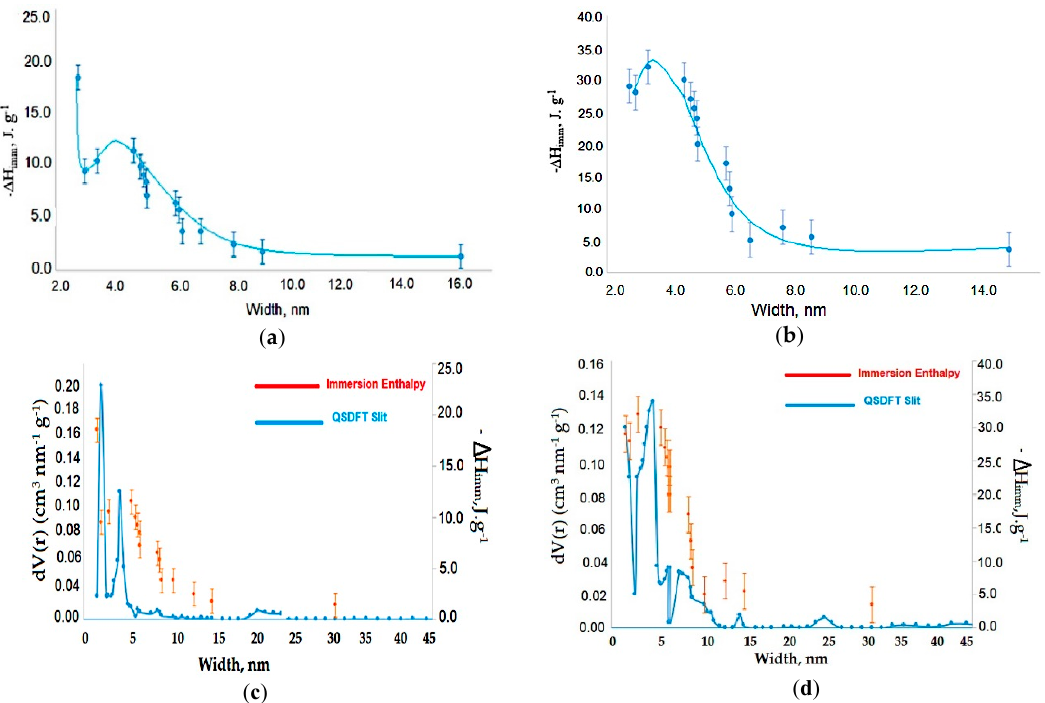
Figure 4. Immersion enthalpy of the probe molecules. ( a ) Immersion enthalpy as a function of kinetic diameter for Gr. ( b ) Immersion enthalpy as a function of kinetic diameter for GO. ( c ) Immersion enthalpies and pore distribution calculated using the QSDFT (slit pore geometry) as a function of the kinetic diameter of the probe molecules for Gr. ( d ) Immersion enthalpies and pore distribution calculated using the QSDFT (slit pore geometry) as a function of the kinetic diameter of the probe molecules for GO.